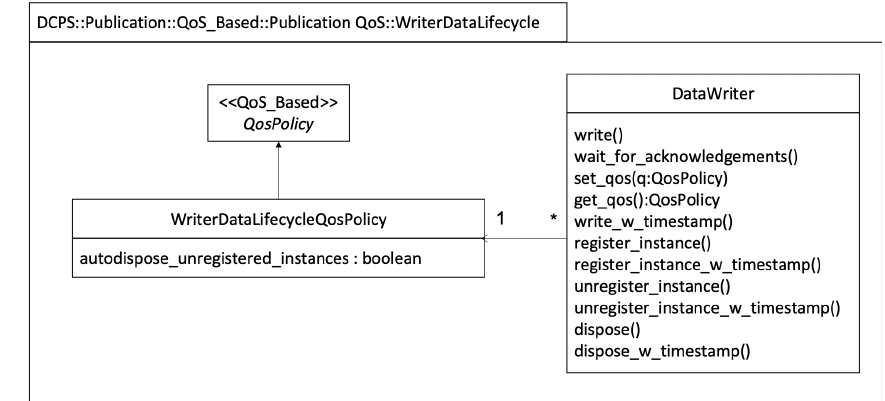
Figure 11. WriterDataLifecycle